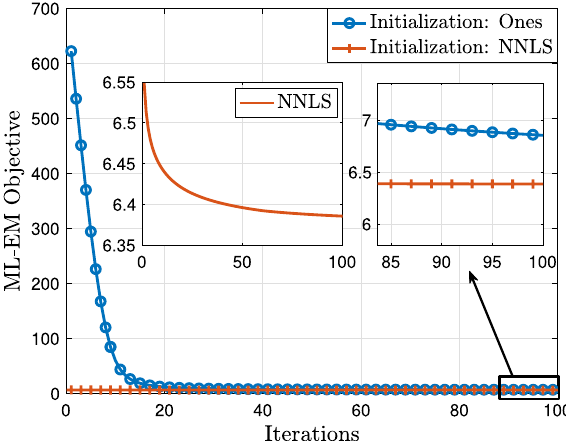
Fig. 5 Convergence behavior of ML-EM algorithm with NNLS and all ones